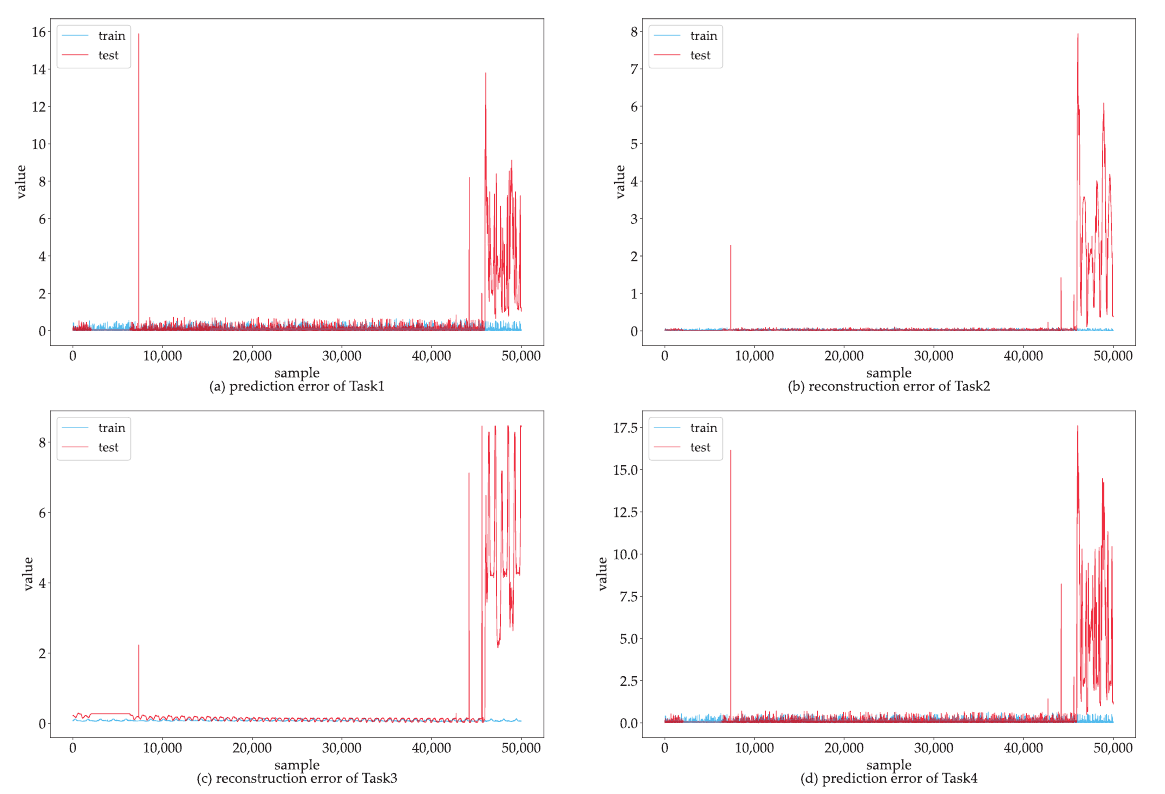
Figure 6. ( a , d ) Task 1 and 4 prediction errors, respectively, and ( b , c ) Task 2 and 3 reconstruction errors, respectively, on training (blue) and test (red) data.